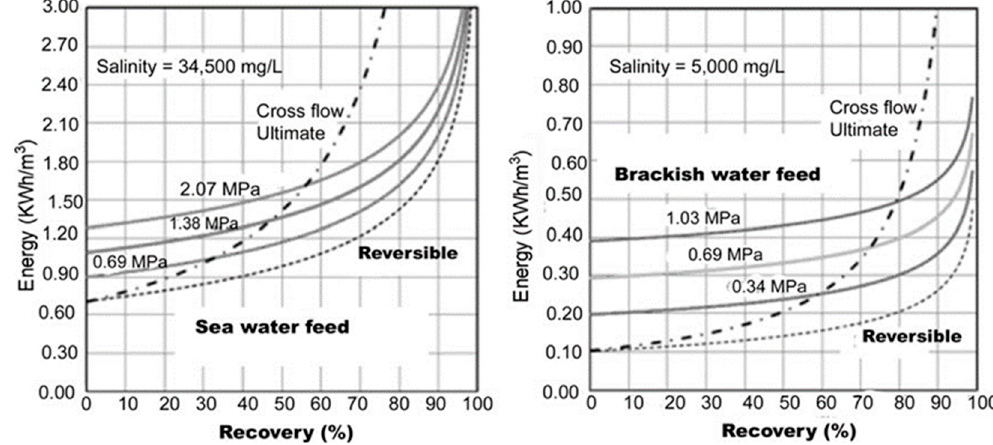
Figure 19. Energy requirement of RO desalination (Seawater & brackish water feed) [9].